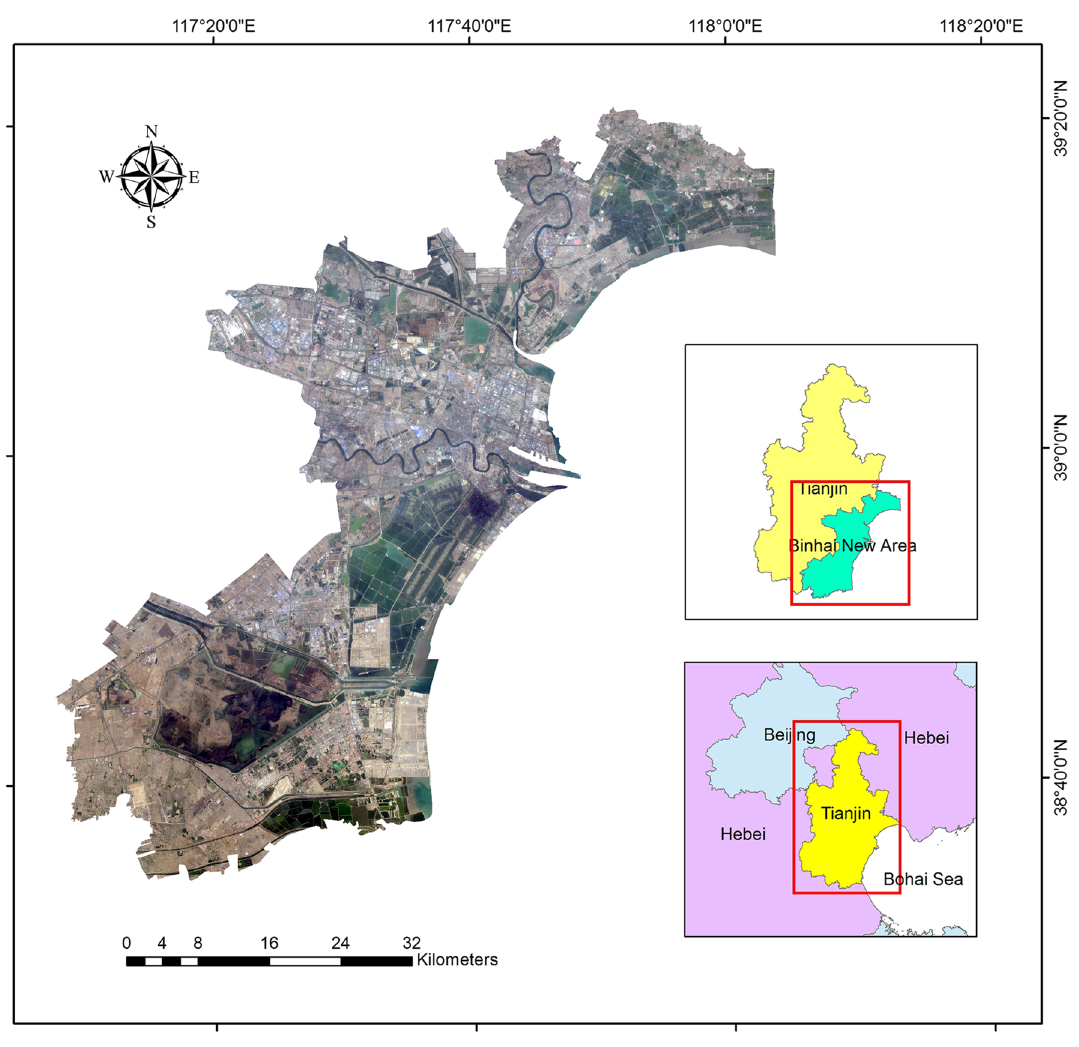
Fig. 1 Location of the study